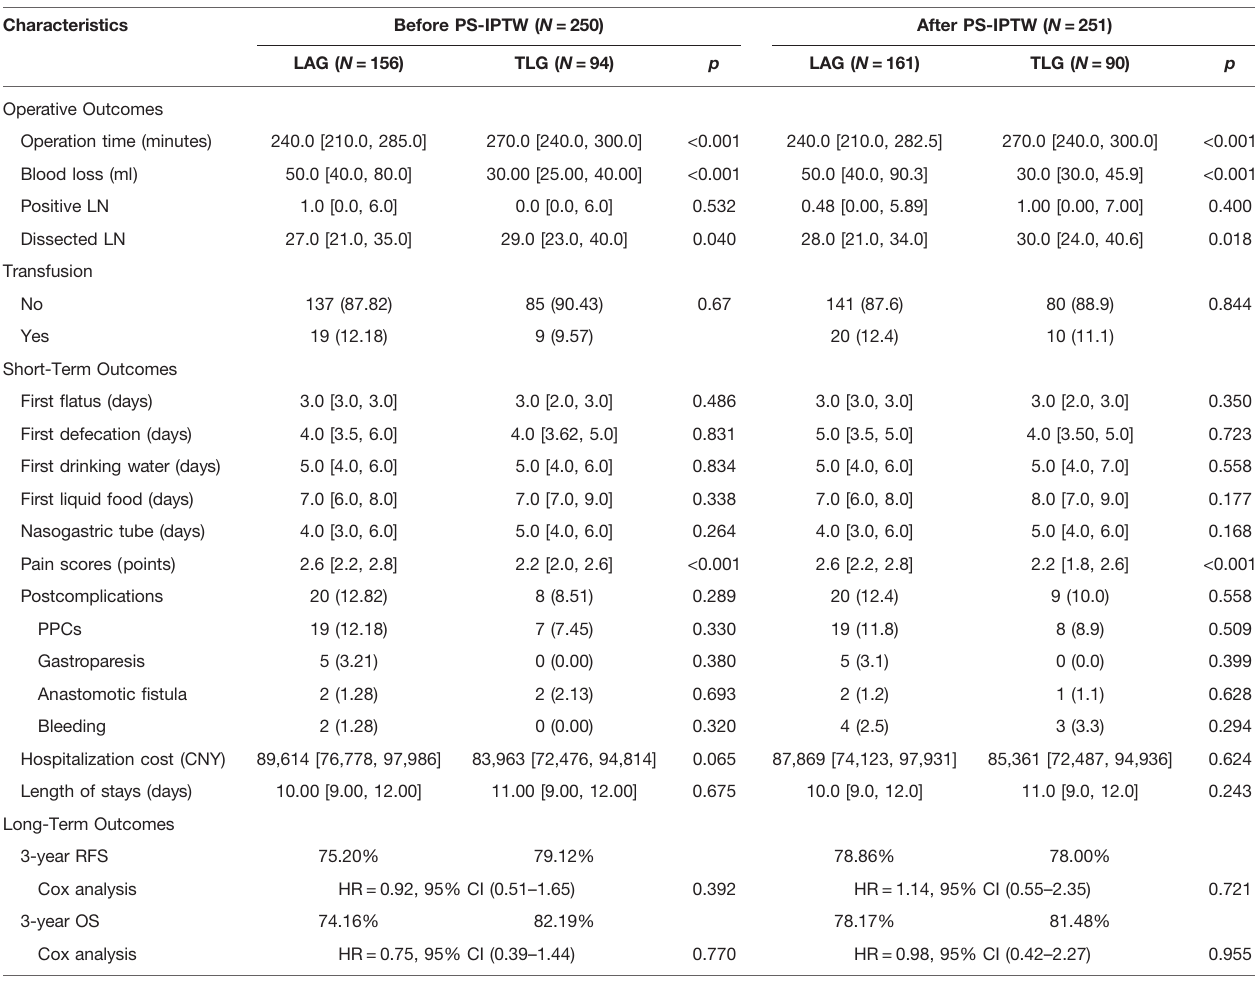
TABLE 4 | Characteristics of operative and prognosis outcomes.